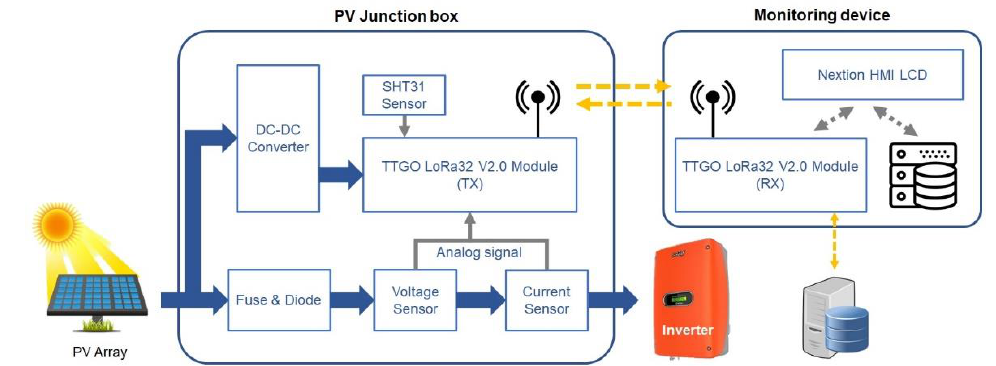
Figure 5. The schematic diagram of the proposed PV junction box monitoring system.